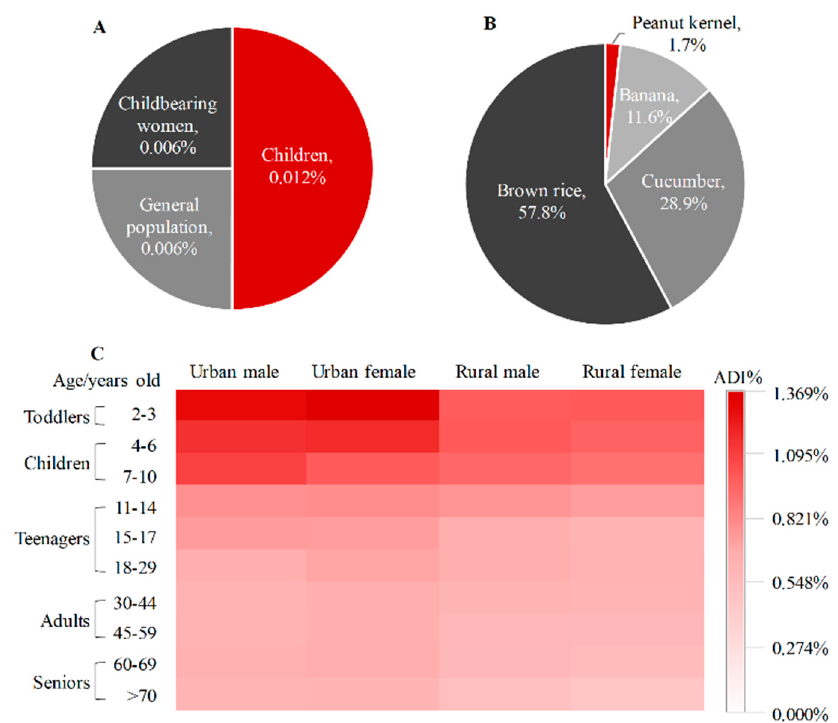
Figure 3. ( A ) Acute dietary risks of total fluxapyroxad in peanut kernel for three group consumers; ( B ) proportion of exposure risk of total fluxapyroxad in registered crops; ( C ) chronic dietary risks of total fluxapyroxad in crops for various groups consumers.